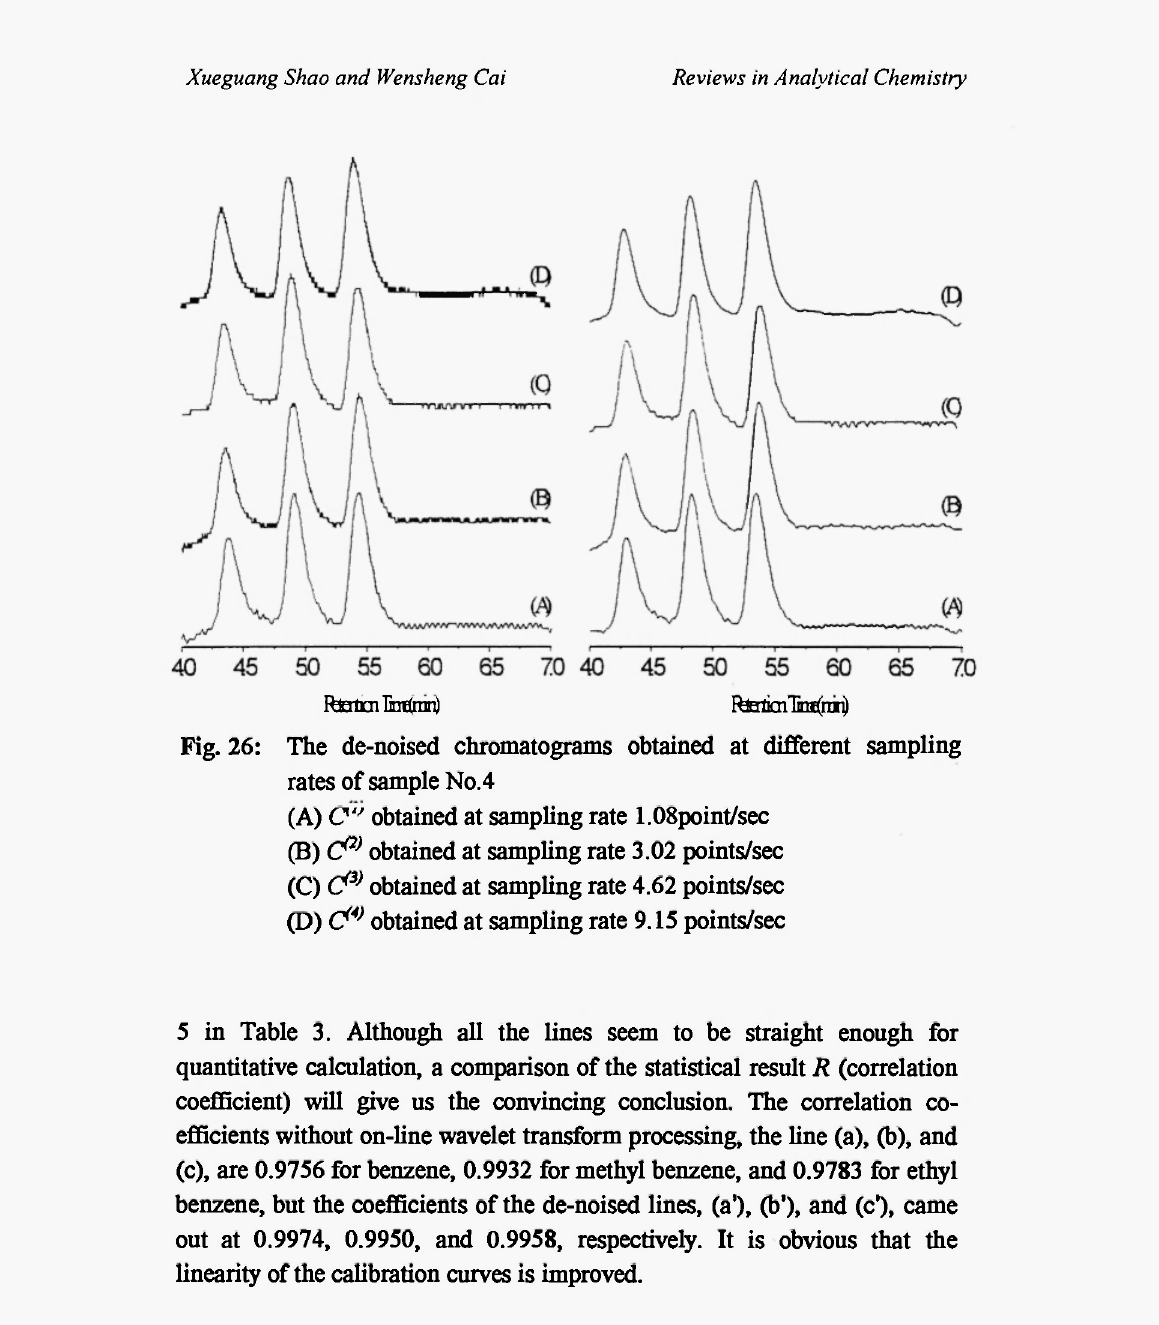
Fig. 26: The de-noised chromatograms obtained at different sampling rates of sample